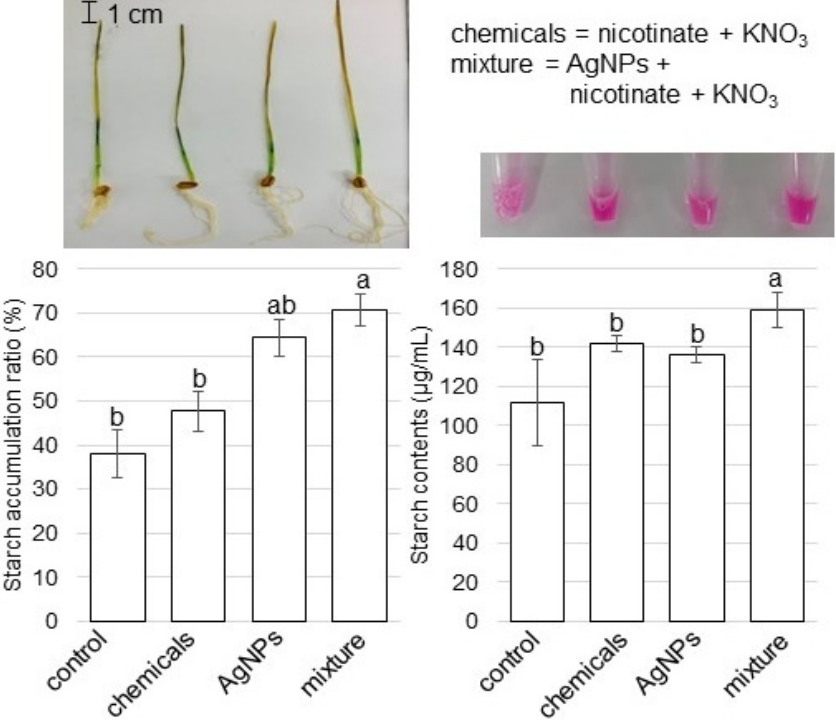
Figure 6. Accumulation ratio and contents of starch in leaves of wheat treated with AgNPs/nicotinate/KNO 3 . Three-day-old wheat seedlings were treated with and without 8 mM nicotinate/0.1 mM KNO 3 (chemicals), 5 ppm AgNPs, and 5 ppm AgNPs/8 mM nicotinate/0.1 mM KNO 3 (mixture) for 3 days. Starch content was analyzed using a Starch Assay Kit and starch accumulation was measured with leaves stained by iodine solution. Scale bar in the picture shows 1 cm. The data are presented as mean ± SD from 3 independent biological replicates. Statistical analysis is the same as Figure 2.